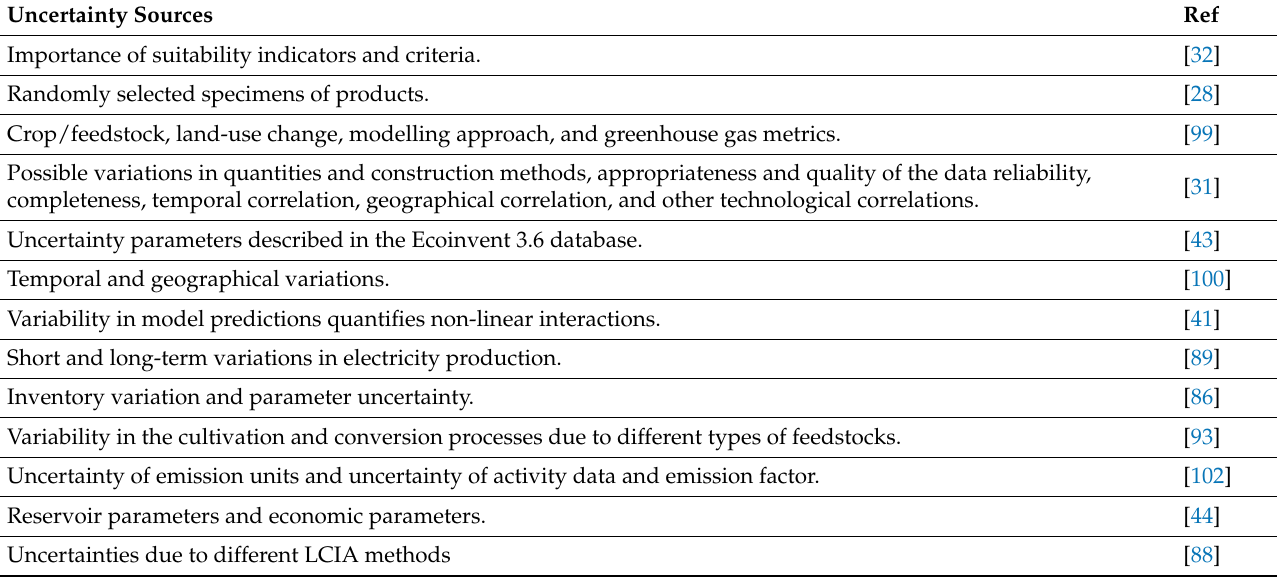
Table 8. Sources of uncertainties reported in the selected